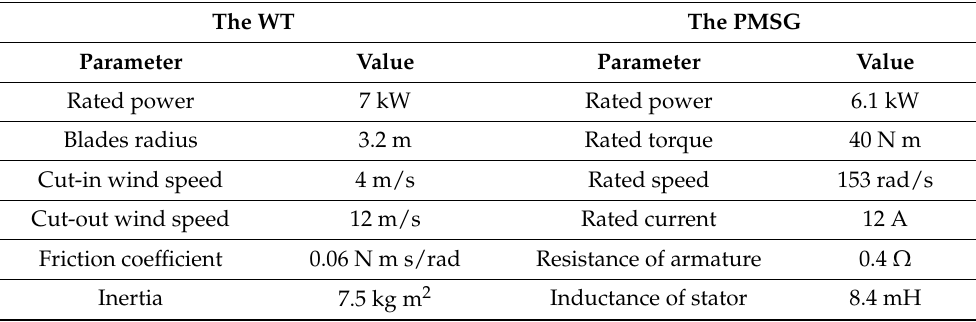
Table 2. Specifications of the wind energy production system.